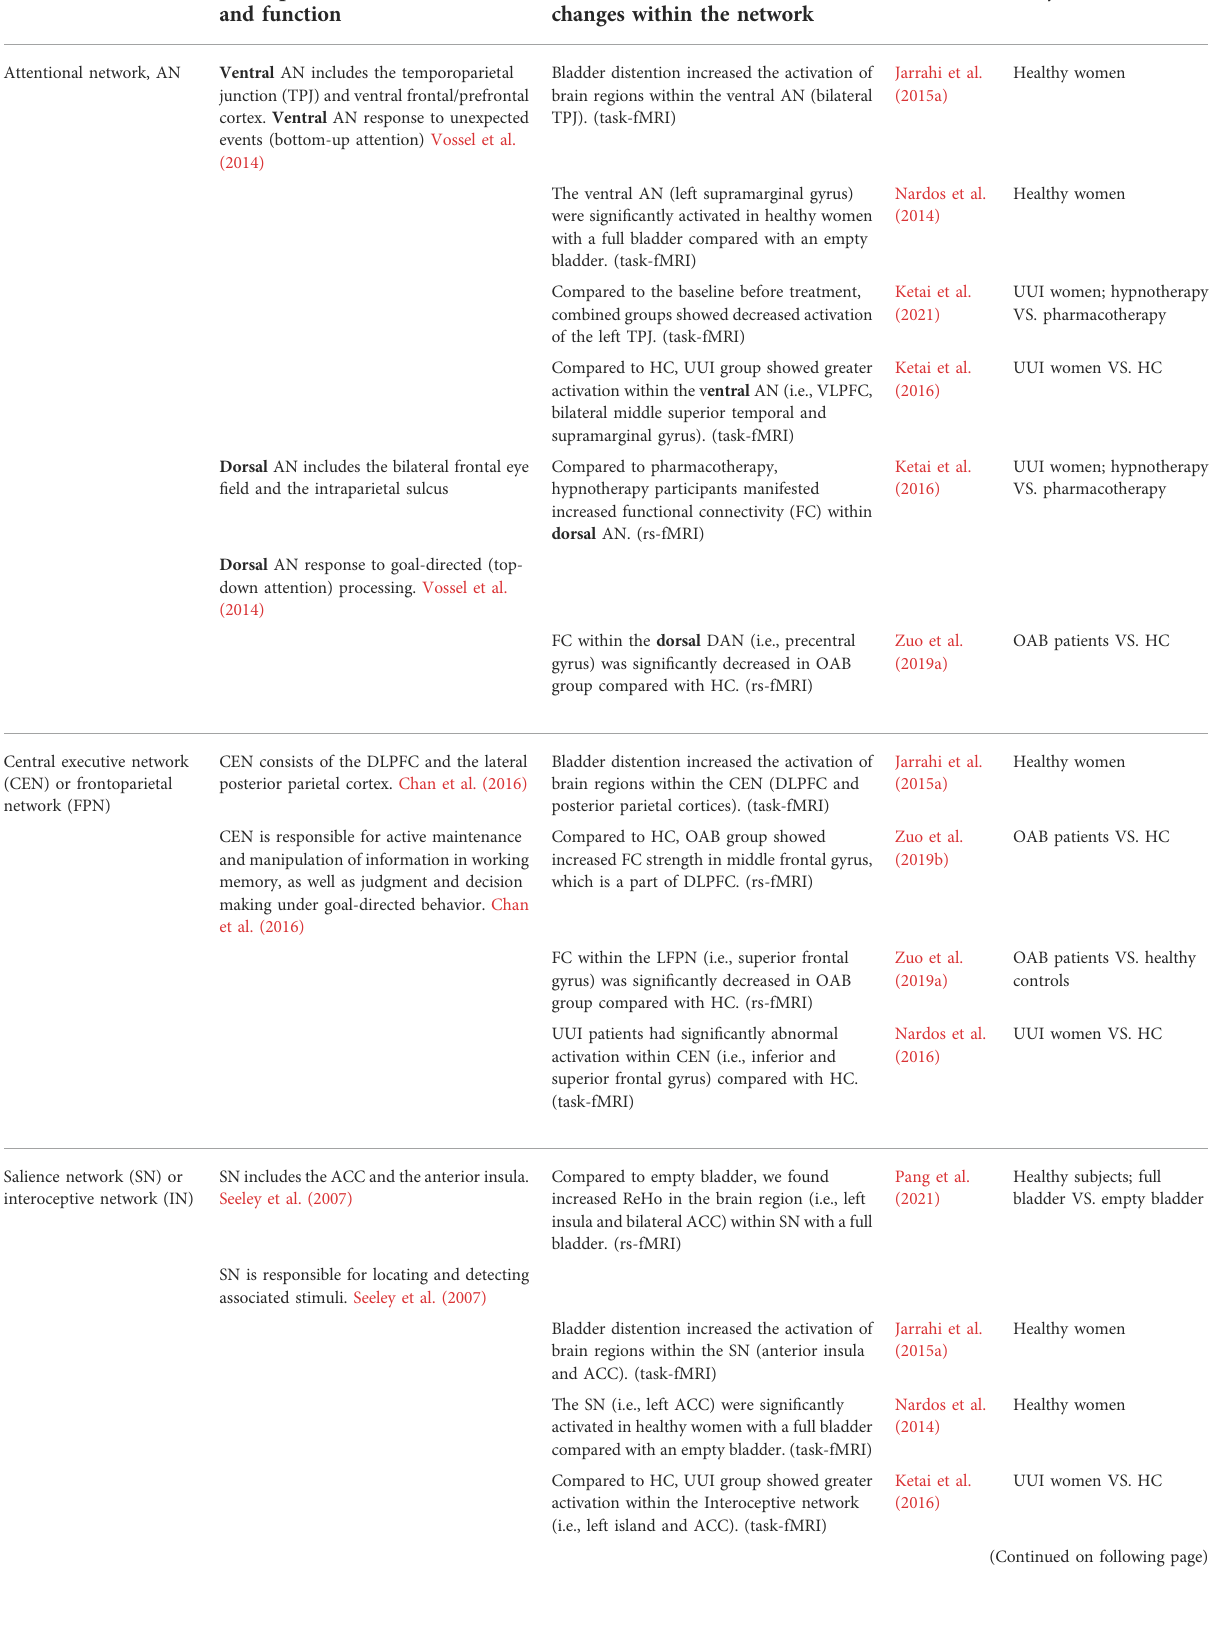
TABLE 2 Changes in the brain FC and networks related to bladder control in healthy subjects and patients with LUTD.